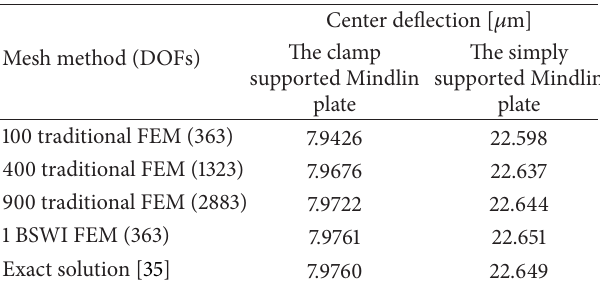
Table 5: Comparison of center deflection of the simply supported Mindlin plate under uniform load (stochastic